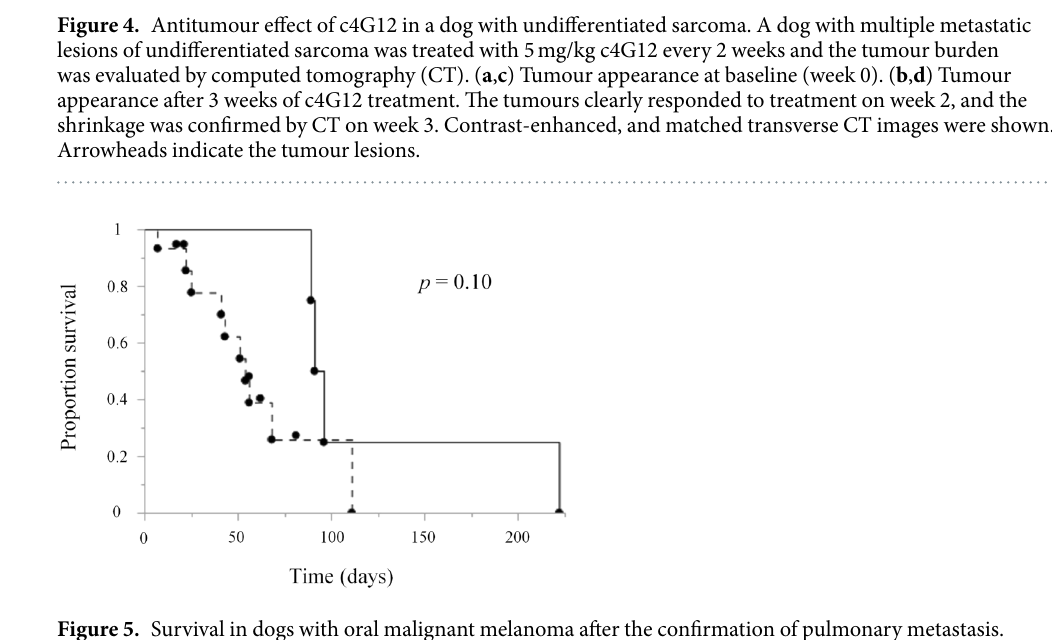
Figure 5. Survival in dogs with oral malignant melanoma after the confirmation of pulmonary metastasis. Survival (days) from the confirmation of pulmonary metastasis to death was recorded and plotted on the graph to generate Kaplan-Meier curves. The c4G12 treatment group ( n = 4, black line) may have had prolonged survival compared to historical control group ( n = 15, dashed line) treated by standard therapies at Veterinary Teaching Hospital during 2013 to 2016. Dots above the line indicate censored data (5 dogs in the control group were censored at 17, 21, 56, 62 and 81 days). Statistical analysis was performed with a log-rank